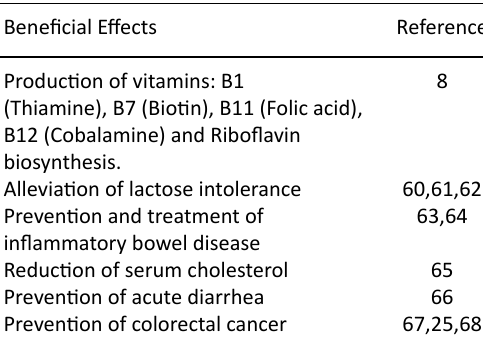
Table 1. Beneficial effects of Bifidobacterium